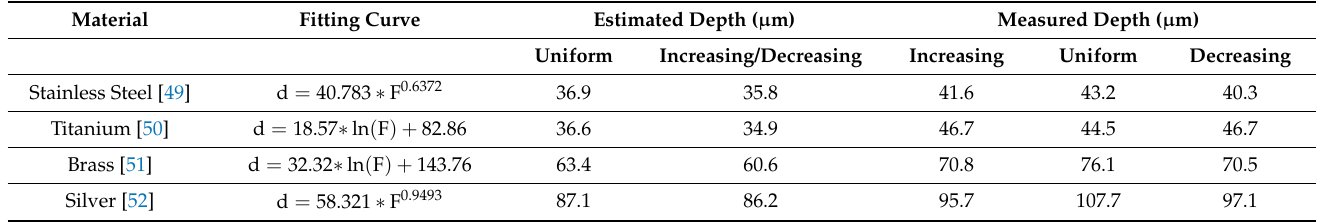
Table 1. Comparison of the experimentally measured depths with calculated depths from ablation rate-fitting curves for the materials involved in this study based on the literature: d is the single pulse ablated depth (in nm) and F is the peak fluence in J/cm 2 . The estimated depth in µ m was calculated for 320 pulses from the fitting equations in the case of uniform and gradient energy irradiations and compared with the experimental depth measurements.